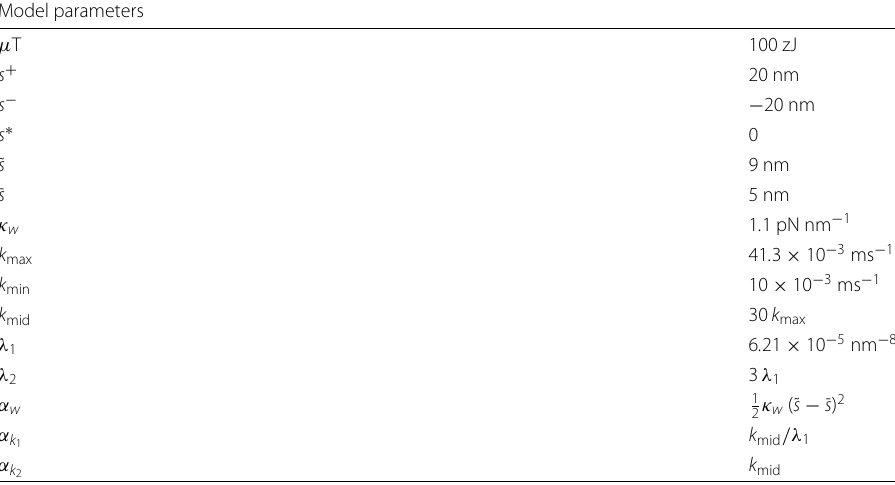
Table1 Model parameters used in the simulations with the Huxley’57 model Model